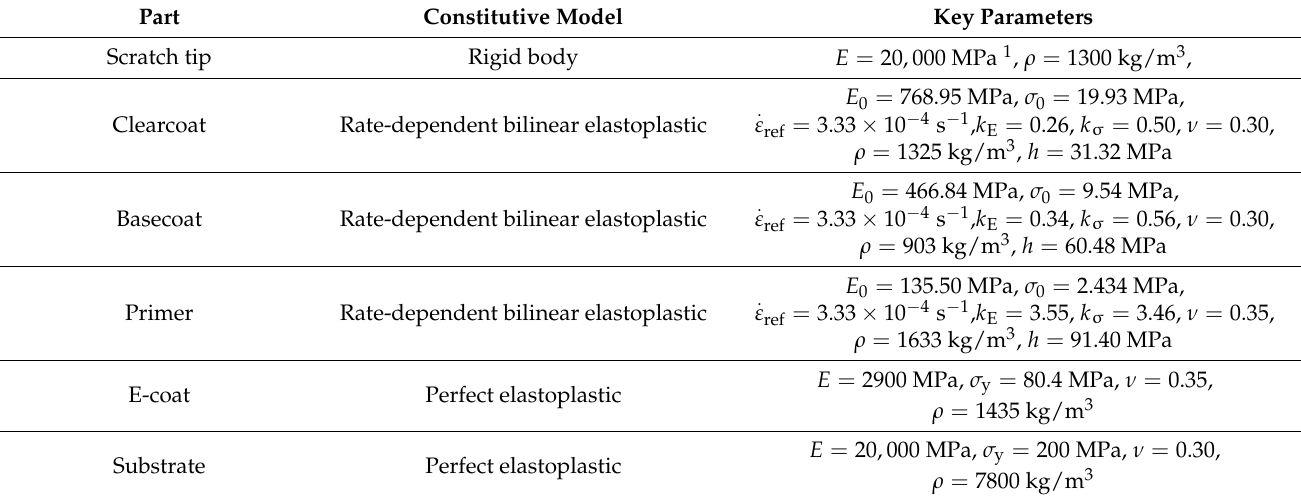
Table 2. Material parameters of the automotive coating scratch model.